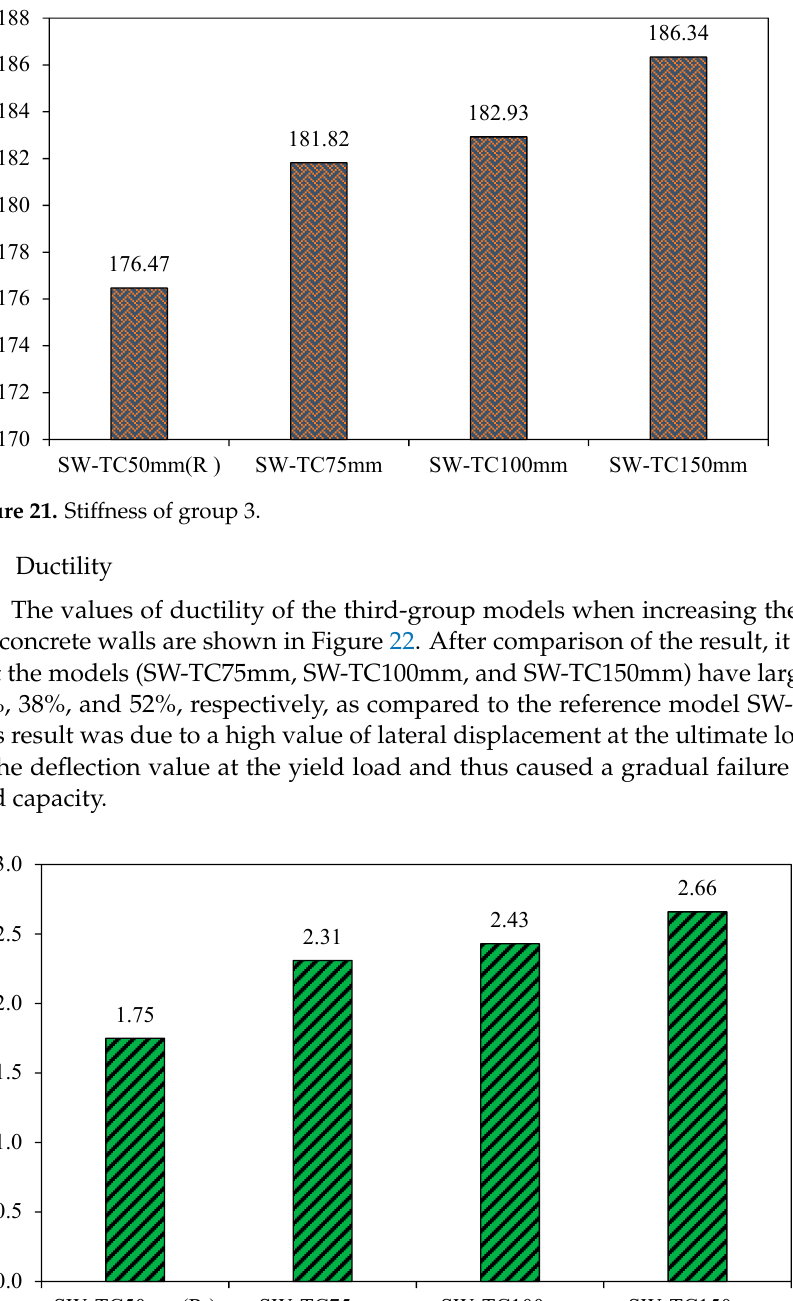
Figure 22. Ductility ratio of group 3.